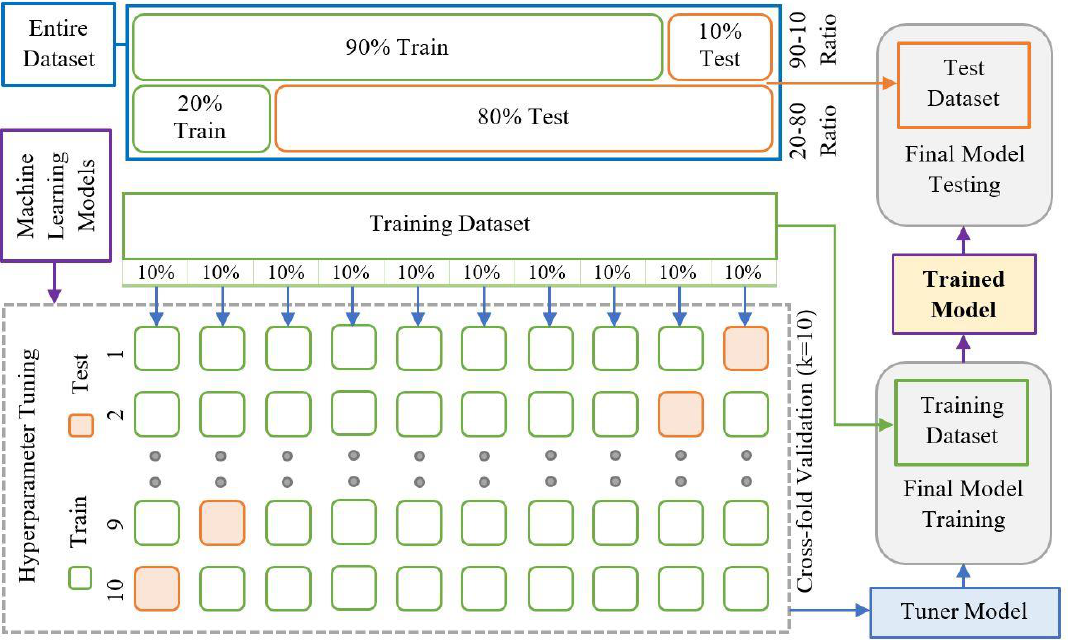
Figure 3. Details of hyperparameter training.